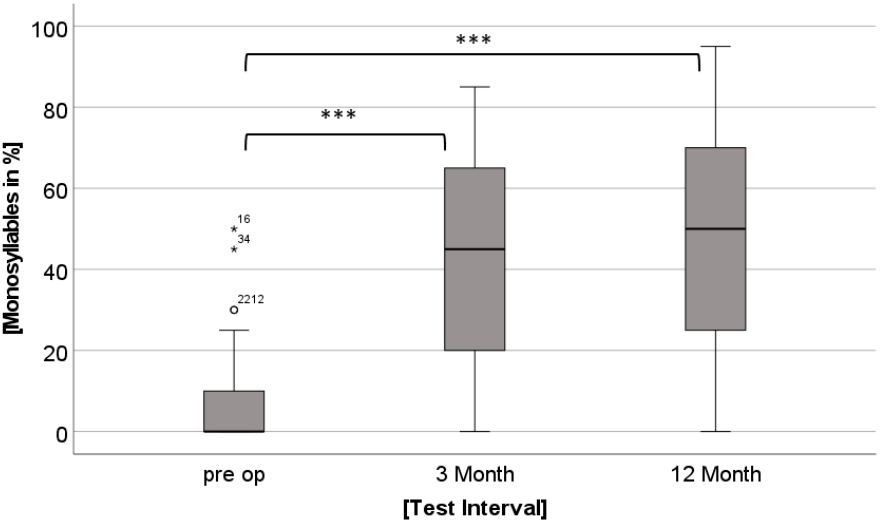
Figure 4. Monosyllables (MS) scores at each test interval. Small circles with numbers indicate outliers. ◦ means outliers, * means significant differences p ≤ 0.05, *** means significant differences p ≤ 0.001.